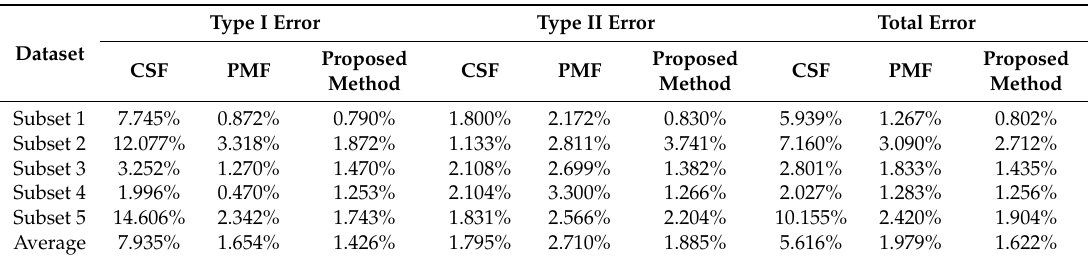
Figure 10. Top views ( a1 , b1 , c1 , d1 , e1 ) and cross-section views ( a2 , b2 , c2 , d2 , e2 ) of filtering results obtained using the proposed method. ( a1 , b1 , c1 , d1 , e1 ) are top views of the filtering results of Subset 1, Subset 2, Subset 3, Subset 4 and Subset 5, respectively; ( a2 , b2 , c2 , d2 , e2 ) are cross-section views of challenging areas in Subset 1, Subset 2, Subset 3, Subset 4 and Subset 5, respectively. The location of the cross-section views in ( a2 , b2 , c2 , d2 , e2 ) are marked by red lines in ( a1 , b1 , c1 , d1 , e1 ), respectively. Table 2. Type I error, type II error and total error of filtering results using cloth simulation filtering (CSF), progressive morphological filtering (PMF), and the method proposed in this paper.